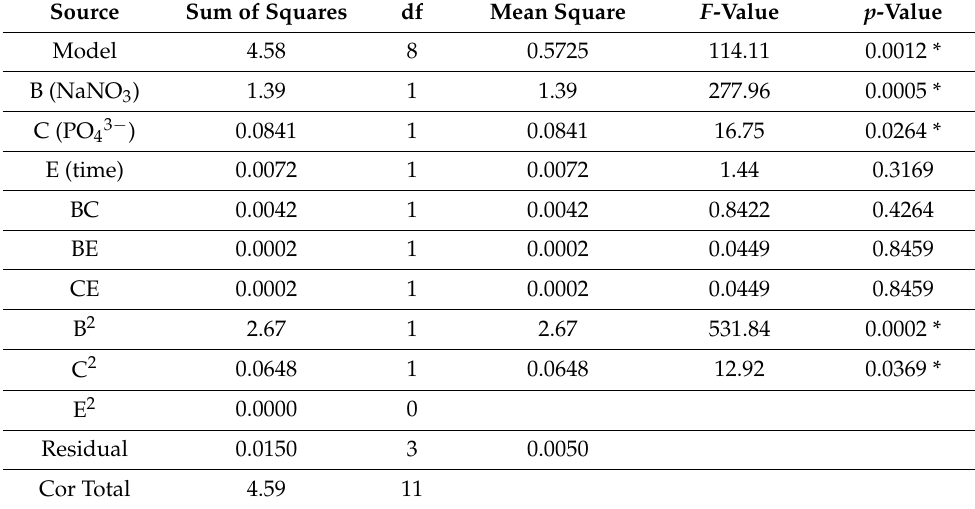
Table 3. Analysis of variance (ANOVA) for regression model of Box Behnken experiment.